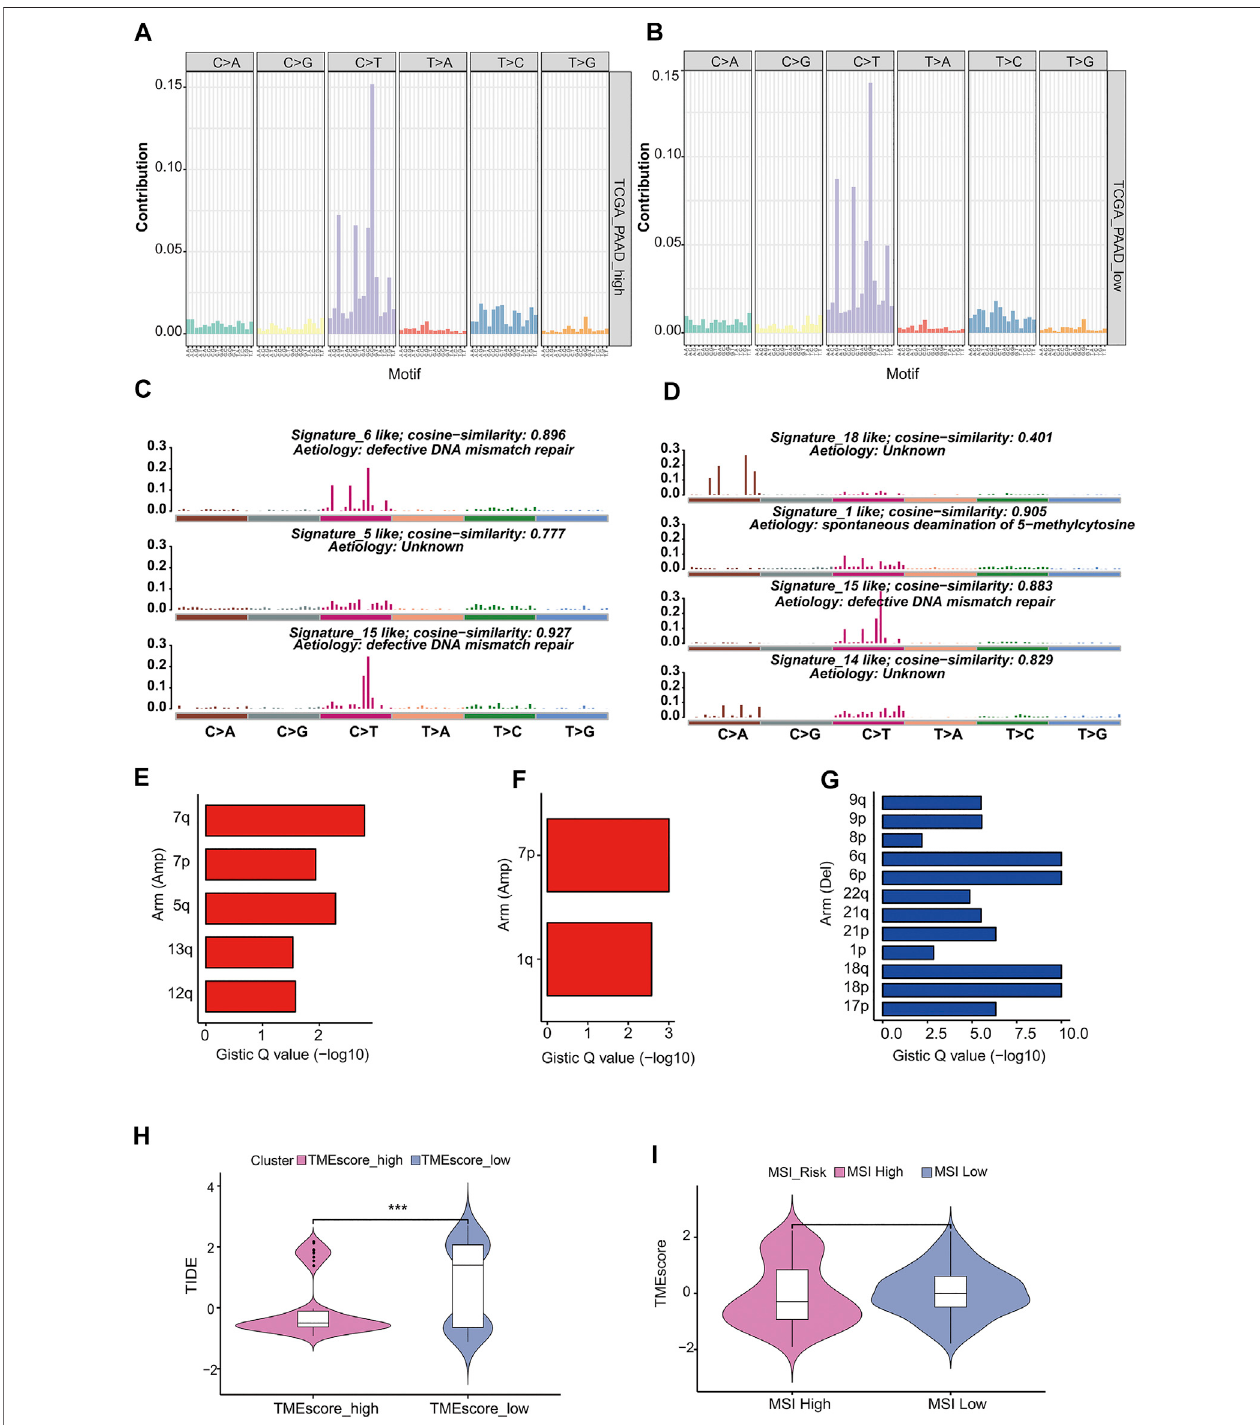
FIGURE 5 | Analysis of mutation characteristics in TMEscore-high and TMEscore-low models. (A) Frequency distribution of 96 mutant types of tumors in the high TMEscore group. (B) Frequency distribution of 96 mutant types of tumors in the low TMEscore group. (C) Mutation signatures of the TMEscore-high group were comparedwiththesimilarityofCOSMICdates. (D) MutationsignaturesofTMEscore-lowgroupwerecomparedwiththesimilarityofCOSMICdates. (E) TMEscore-high/ low chromosome arm ampli fi cation. (F) TMEscore-high/low chromosome arm ampli fi cation. (G) Deletion of chromosome arm level in low TMEscore group. (H) Prognosis prediction of immune checkpoint treatment. (I) Relationship between MSI risk and TMEscore.